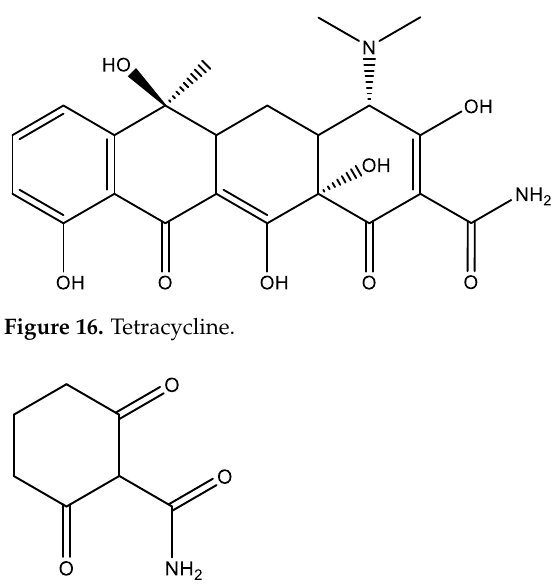
Figure 17. 2-carbamoyl-1,3-cyclohexanedione shown on the keto-form.